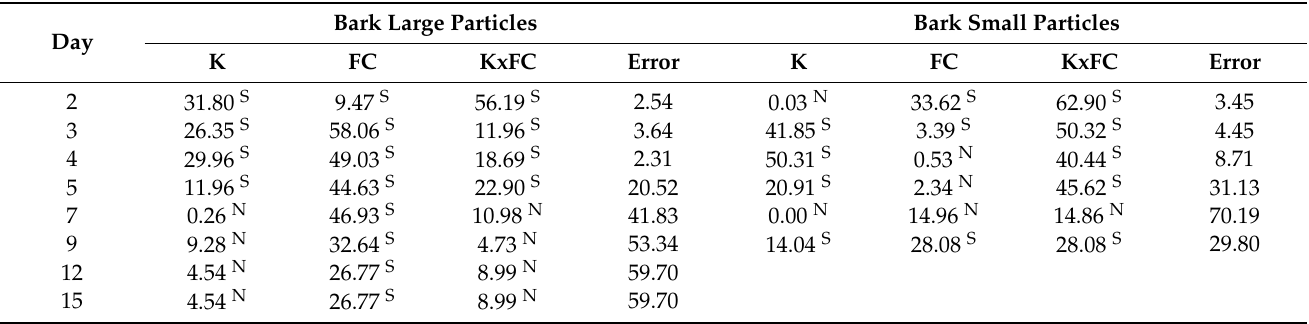
Table 5. Percentage of the compatibilizer influence, filler fraction and their interactions influencing the mold growth on PLA